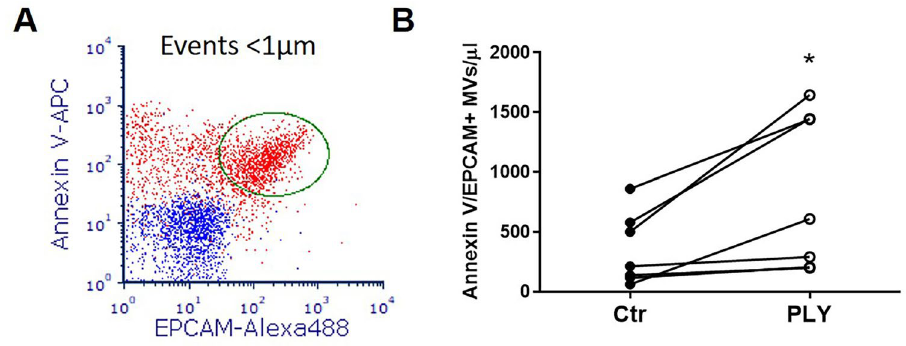
Figure 3. Ex vivo production of lung epithelial microvesicles (MVs). Human lung specimens (pieces from the same lung) were stimulated with PLY (5 μg/ml) or PBS (Ctr). MVs were isolated from the conditioned media 8 h later and analyzed by FACS. ( A ) Representative overlay dot blot of MVs from PLY-treated human lungs. Blue dots represent MVs double stained with isotype and annexin V in the presence of EDTA (negative staining). Red dots represent MVs double stained with annexin V-APC and EPCAM-Alexa488. Epithelial MVs (double positive events) are gated by the ellipse gate (green). ( B ) Graph depicts the quantification of annexin V/EPCAM double positive MVs. Each line represents data derived from different lung specimens (differentially treated) from the same patient. N = 7, *p < 0.05 (paired t-test) .